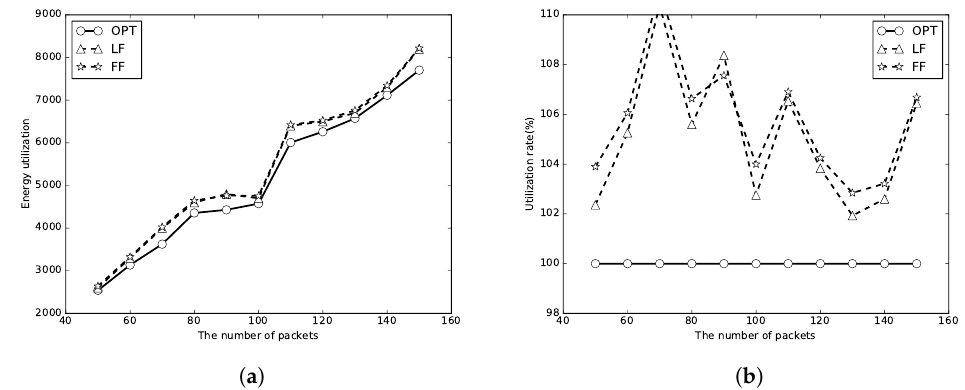
Figure 8. C = E . ( a ) energy utilization; ( b ) energy utilization ratio.